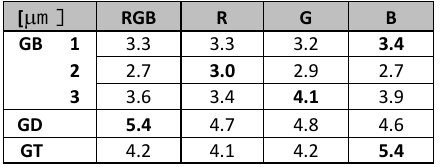
Table 5. Comparison of the decentring distortion correction in 1.9 mm radial distance, independent adjustment. All units in  m. The largest correction value for each dataset is highlighted.